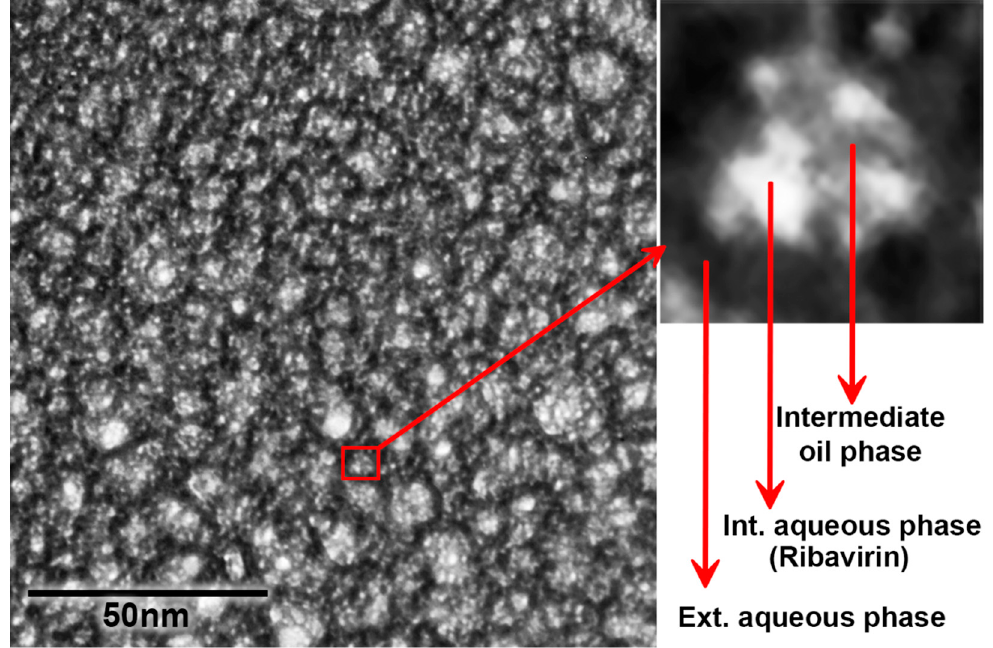
Figure 1. TEM examination of the diluted Carbopol 981 ME negatively stained with Uranyless illustrates the spherical shape and the multilayered structure of the ME globules. The magnified globules clearly show the presence of several water droplets inside the oil droplet, which is surrounded by the continuous external aqueous phase.